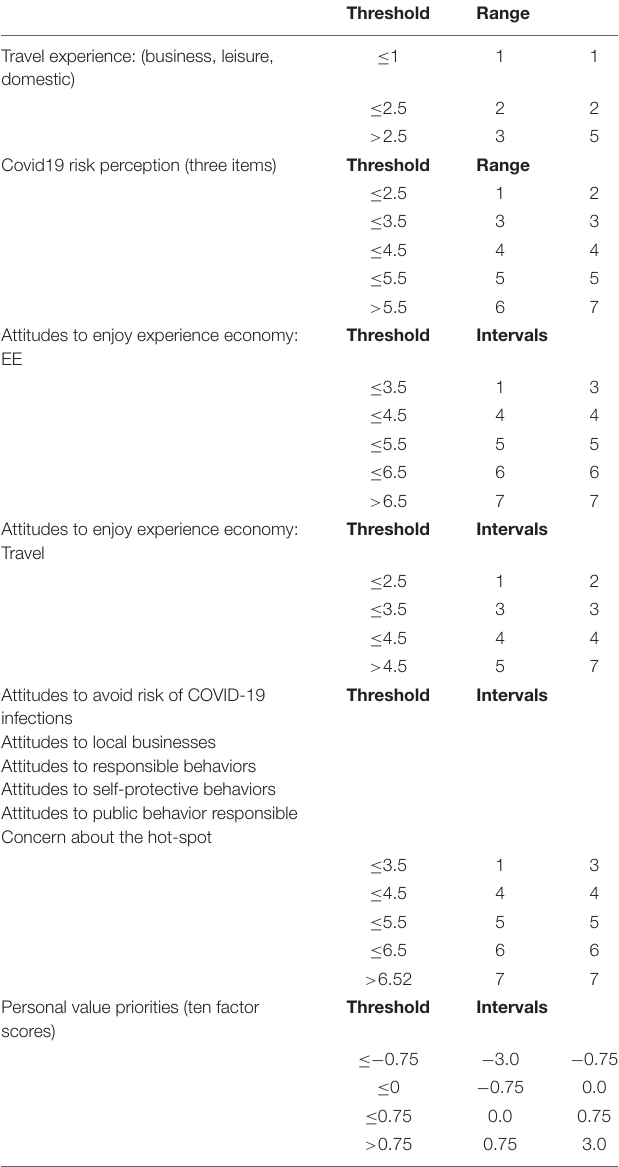
TABLE 3 | Data discretization (thresholds and